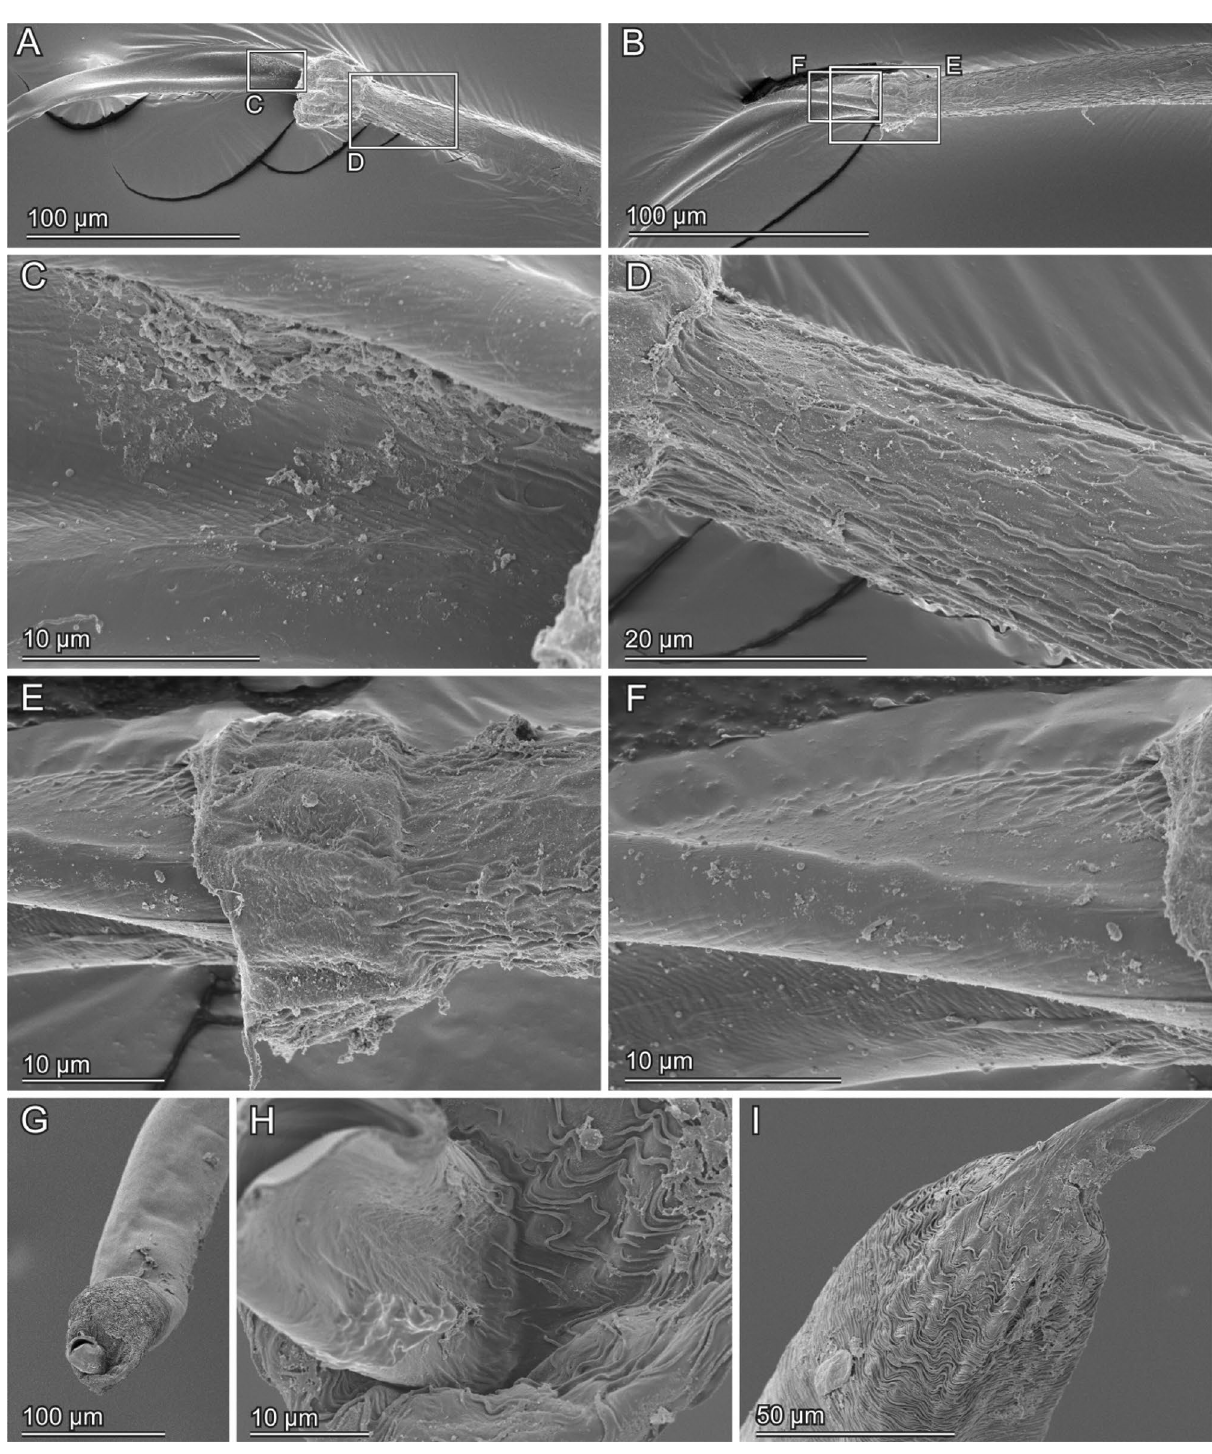
Figure 4. Scanning electron micrographs of the transition zone of the virga of Echinosoma horridum. ( A ) Overview. The inner side. ( B ) Overview. The outer side. ( D – F ) Magnified surfaces marked in images ( A ) and ( B ). ( G – I ) Caudal views of the transition area between the thick-part and thin-tube of the